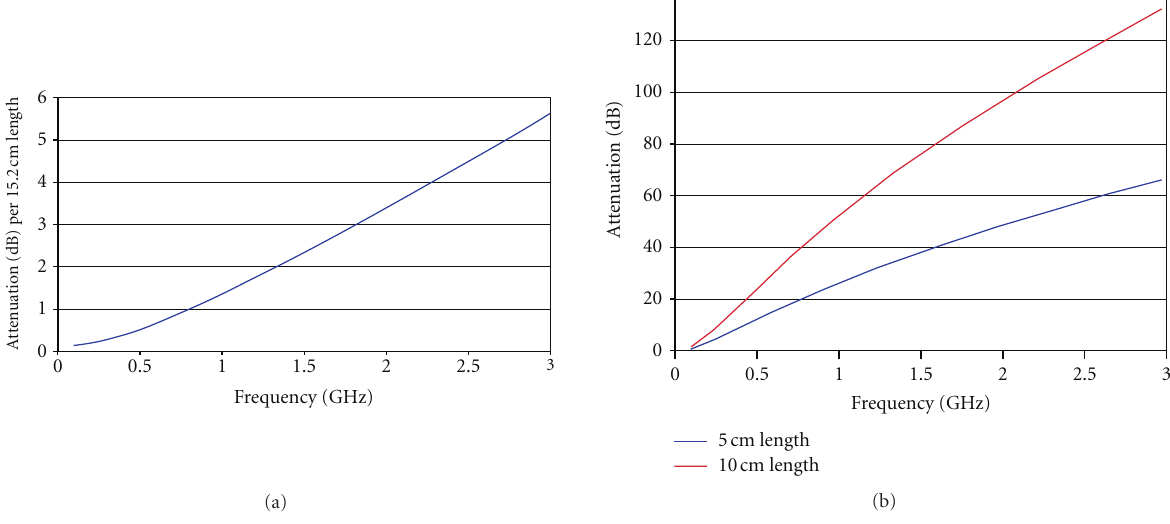
Figure 9: Surface wave attenuation as a function of frequency for (a) the planar mode at the interface between Plexiglas and the bath for a 15.2cm length and (b) the coaxial mode with a lossy dielectric (80:20 glycerin :water bath) surrounding a metal conductor for 5 and 10cm lengths.